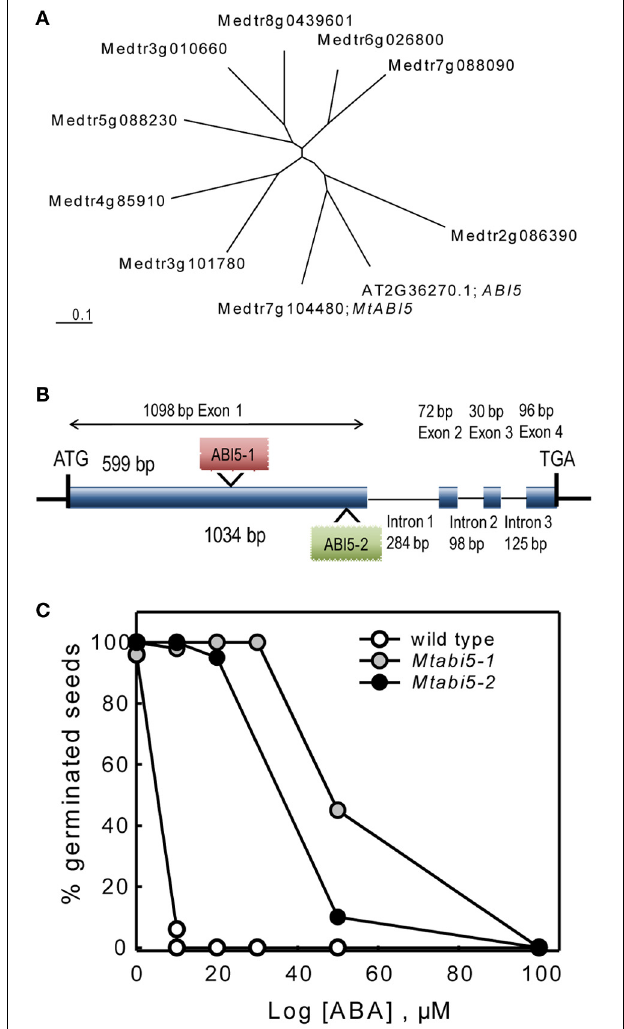
FIGURE 3 | Characterization of abscisic acid insensitive 5 ( Mtabi5 ) mutants of Medicago truncatula . (A) Unrooted tree showing MtABI5 and closest homologs together with the A rabidopsis thaliana ABI5. CLUSTALW was used for alignment and TREEVIEW for graphical output. Gene identifiers correspond to IMGAG Mt3.51 (B) Gene structure of MtABI5 with Tnt1 insertions in Mtabi5-1 and Mtabi5-2 alleles. (C) Percentages